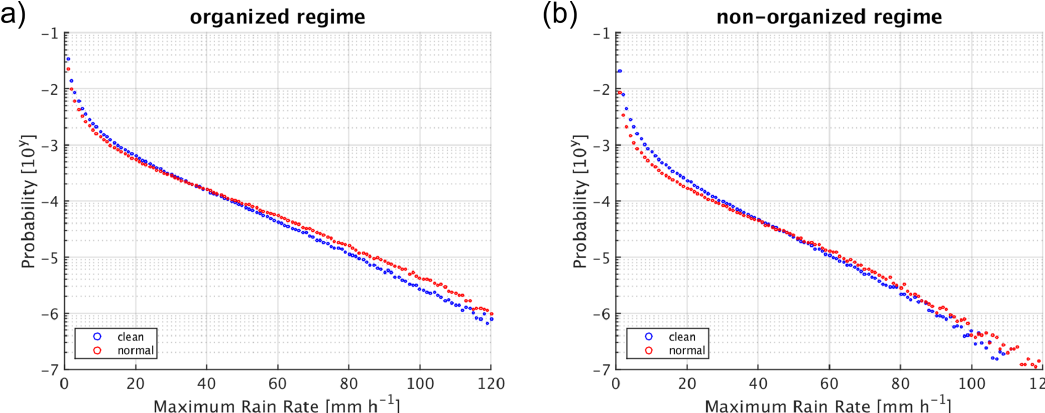
Figure 7. The probability density functions of the maximum rain rates of the convective cloud objects for the (a) organized regime and (b) the non-organized regime. The blue and the red circles represent the results of the clean and the normal scenarios, respectively.